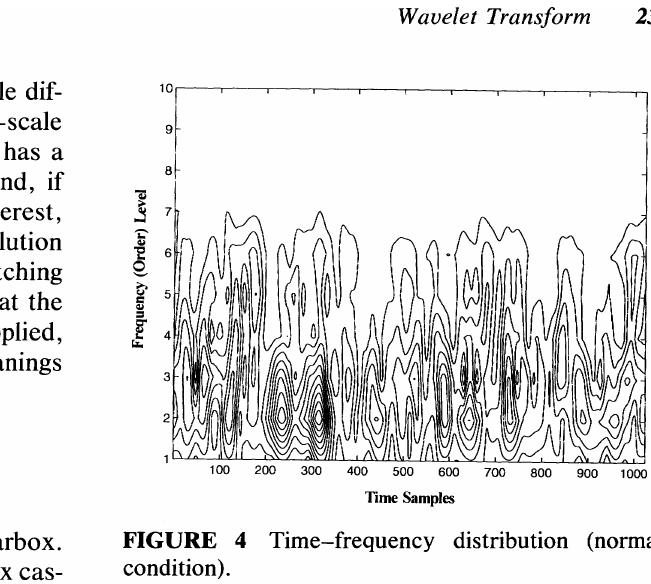
FIGURE 4 Time-frequency distribution (normal condition).